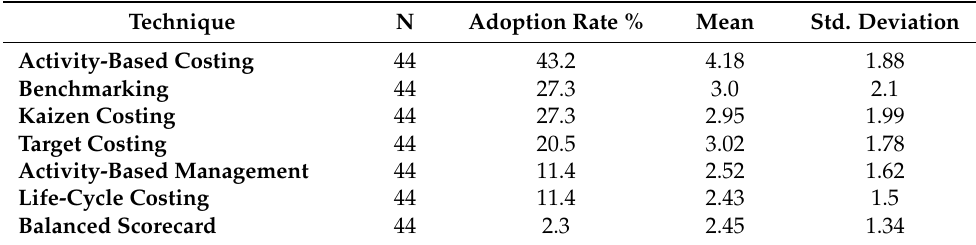
Table 6. Status of MAIs in the manufacturing sector in